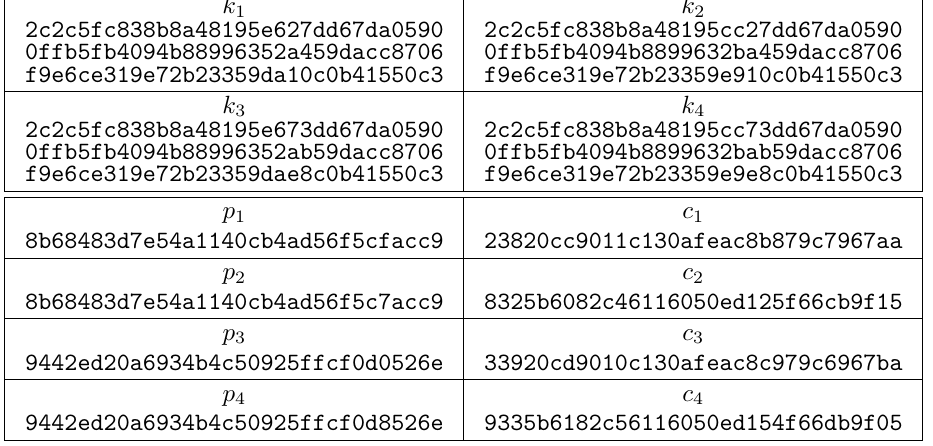
Table 24: A right quartet satisfying boomerang distinguisher I for 22 rounds of SKINNY -128-384